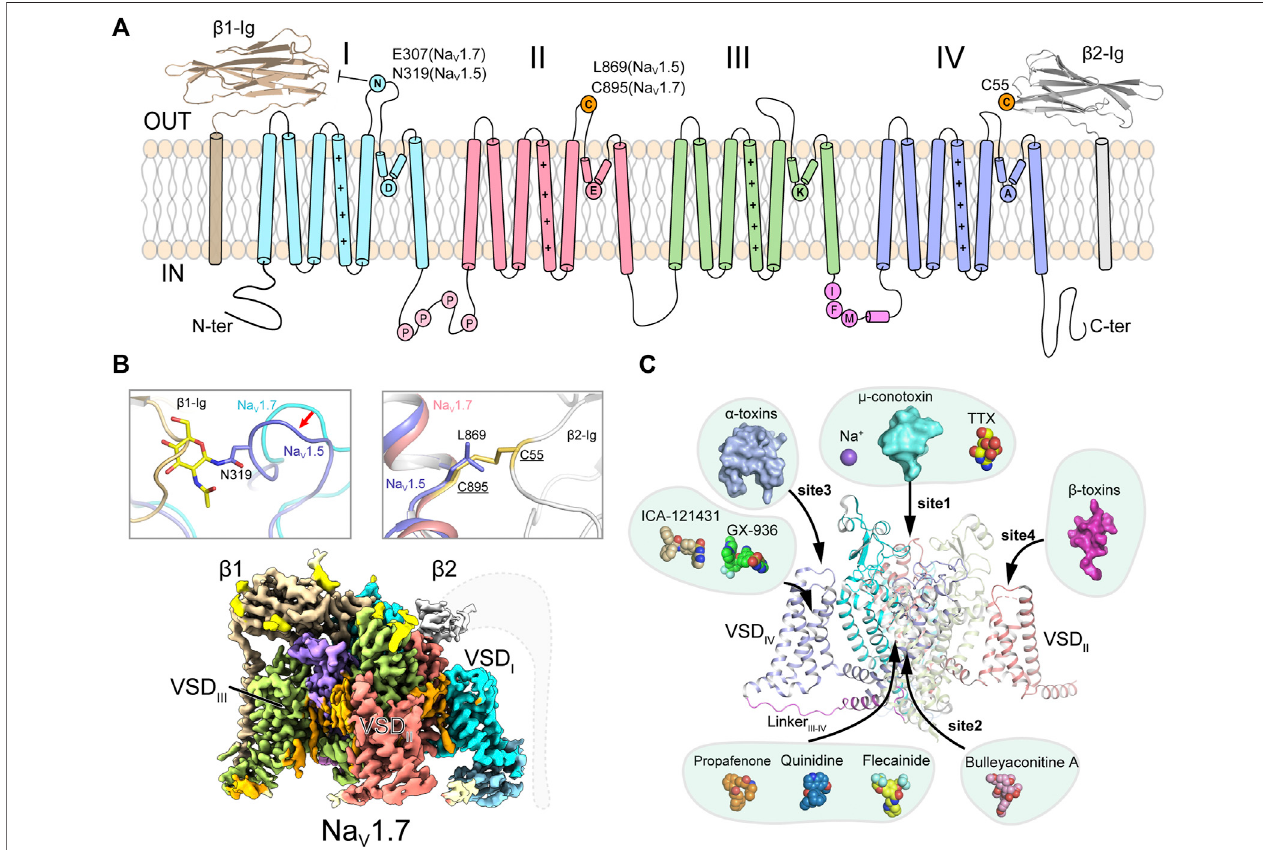
FIGURE1| TopologyandarchitectureofmammalianNa V channels. (A) TopologyofmammalianNa V channels.D I ,D II ,D III ,IFM-motifandD IV of α -subunit, β 1and β 2 subunit are colored in cyan, red, green, purple, blue, brown and gray, respectively. A unique N-glycosylation site in Na V 1.5 and the cysteine residue for linking β 2 are highlighted.Prepresentsphosphorylationsites. (B) SubunitsassemblyofmammalianNa V channels.AsugarmoietyofN319glycosylationandL869blockthebindingof β 1 and β 2 to Na β 1/ β 2 (lower panel, EMDB code: EMD-33292). Dashed lines V 1.5 (PDB code: 6UZ3), respectively (Upper panels). Cryo-EM map of human Na V 1.7/ indicate the invisible region of β 2 subunit. (C) Multiple ligand binding sites in mammalian Na V channel α -subunit. Sodium ion and small-molecule modulators shown in spheres, polypeptide toxins shown in surface.